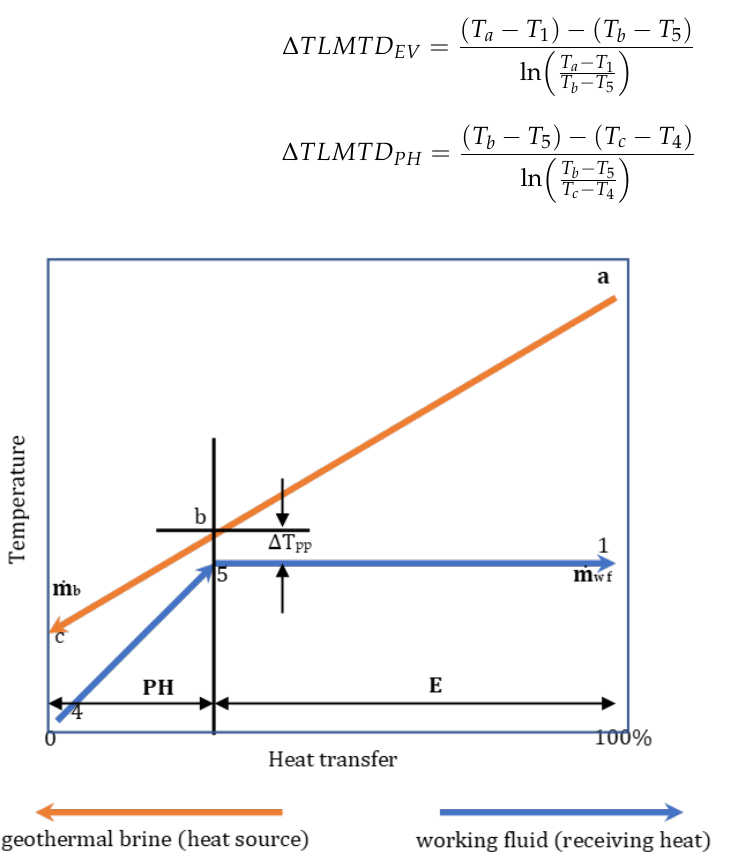
Figure 3. Temperature–heat transfer diagram for preheater and evaporator; geothermal brine enters the evaporator at a and exits at b, enters the preheater and leaves at c to reinjection, while the working fluid enters the preheater at 4 and exits as a saturated liquid at 5, and it enters the evaporator and exits to the turbine at 1 [1].